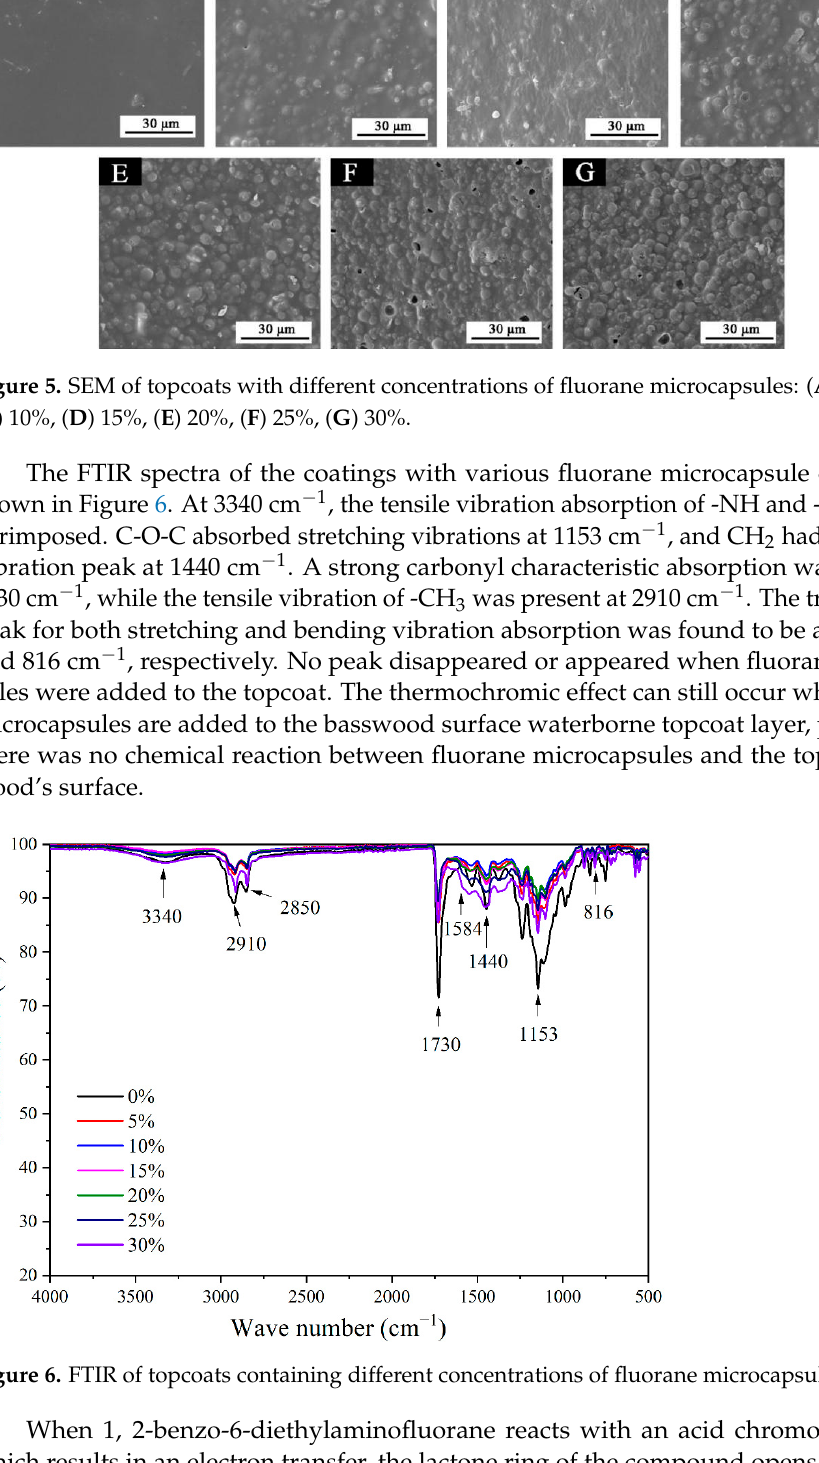
become more and more visible. There were minor holes on the topcoat’s surface when the content was between 25 and 30%, which may have been created by adding too much con- tent.